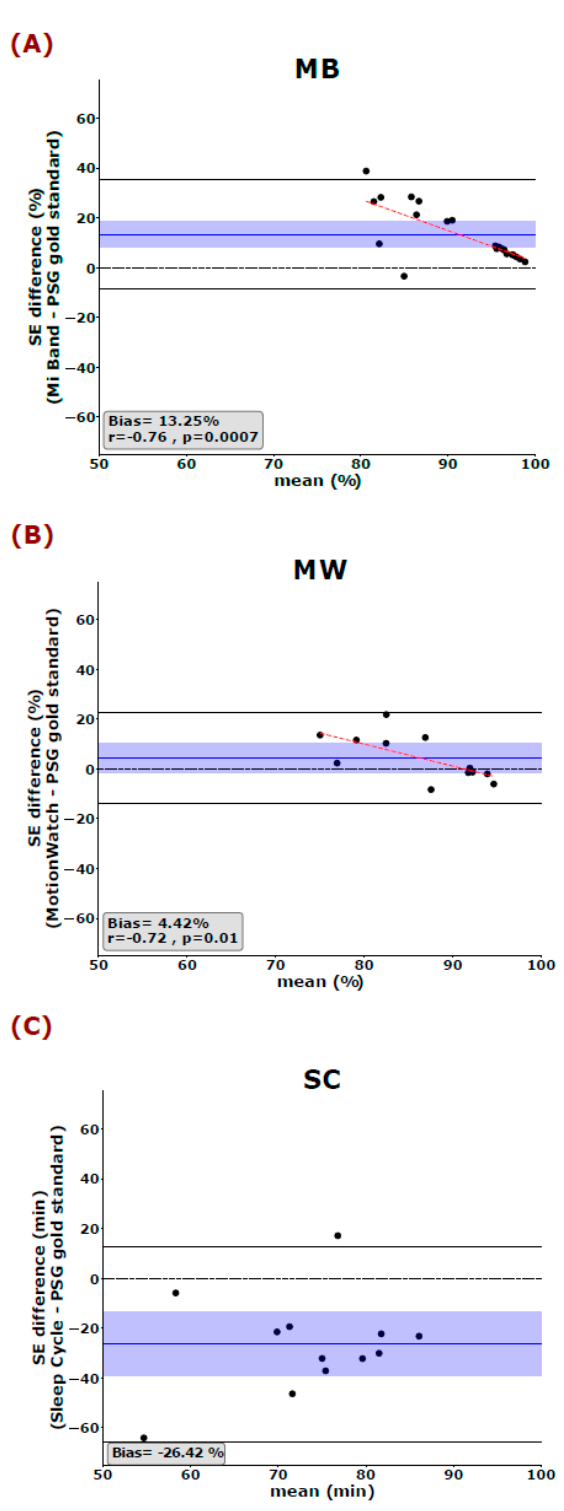
Figure 2. Bland–Altman plots show the PSG gold standard with ( A ) MB, ( B ) MW, and ( C ) SC in measuring sleep e ffi ciency (SE). The blue horizontal line represents the mean di ff erence between the two measurements, and the shaded blue area represents the 95% CI of the mean di ff erence. Black horizontal lines mark the 1.96 SD from the mean. The black dashed line is the line of equality (di ff erence = 0), and the red dashed line represents the Spearman correlation between the di ff erence and the average of the two measurements. SE: Sleep E ffi ciency, MB: Mi Band, MW: MotionWatch, and SC: Sleep